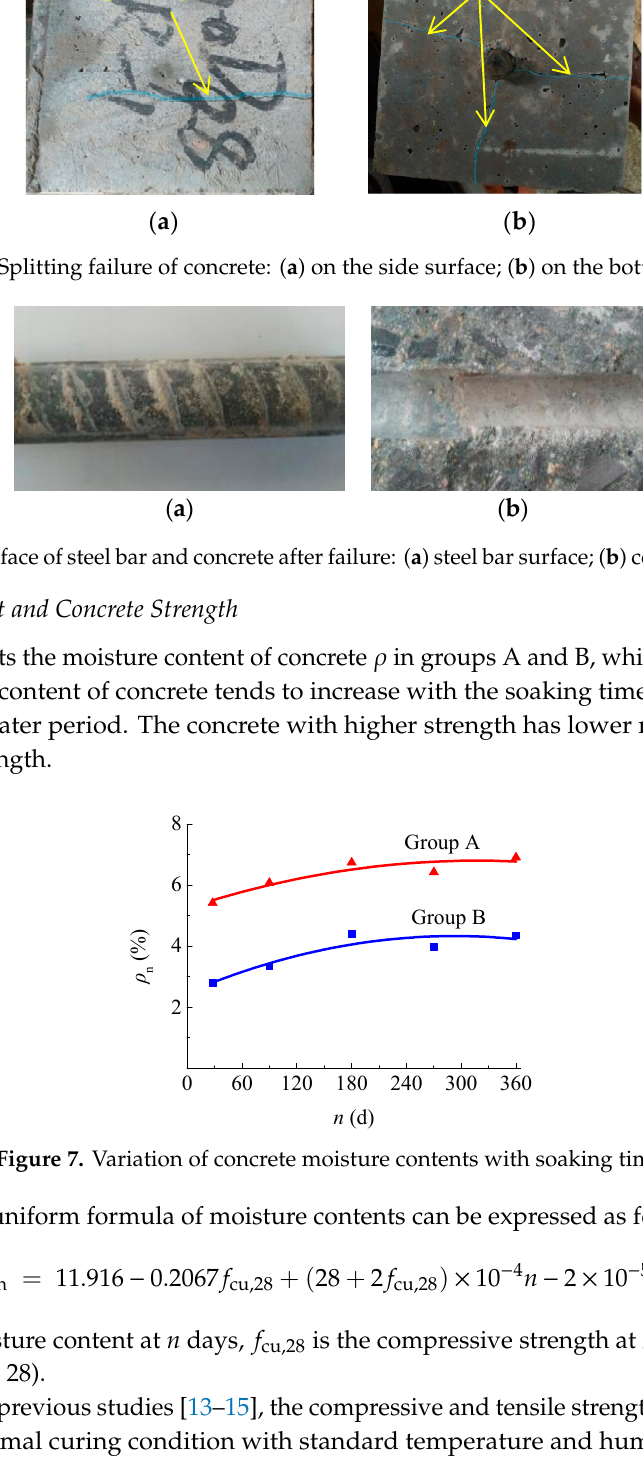
Figure 7. Variation of concrete moisture contents with soaking time.